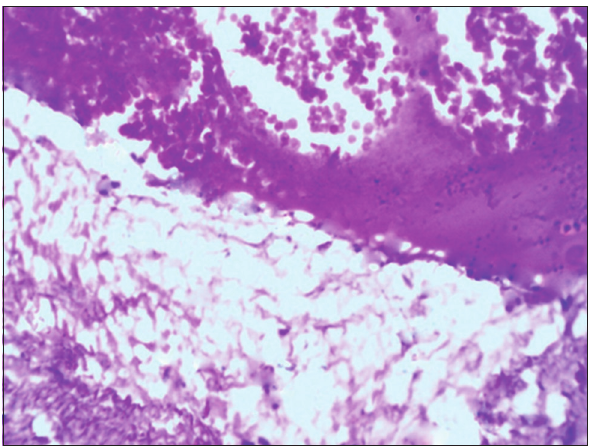
Figure-5: Aorta Group II section showing severe endothelial degeneration, foam cell accumulation with initiated atheromatous plaque (H and E, 400×).